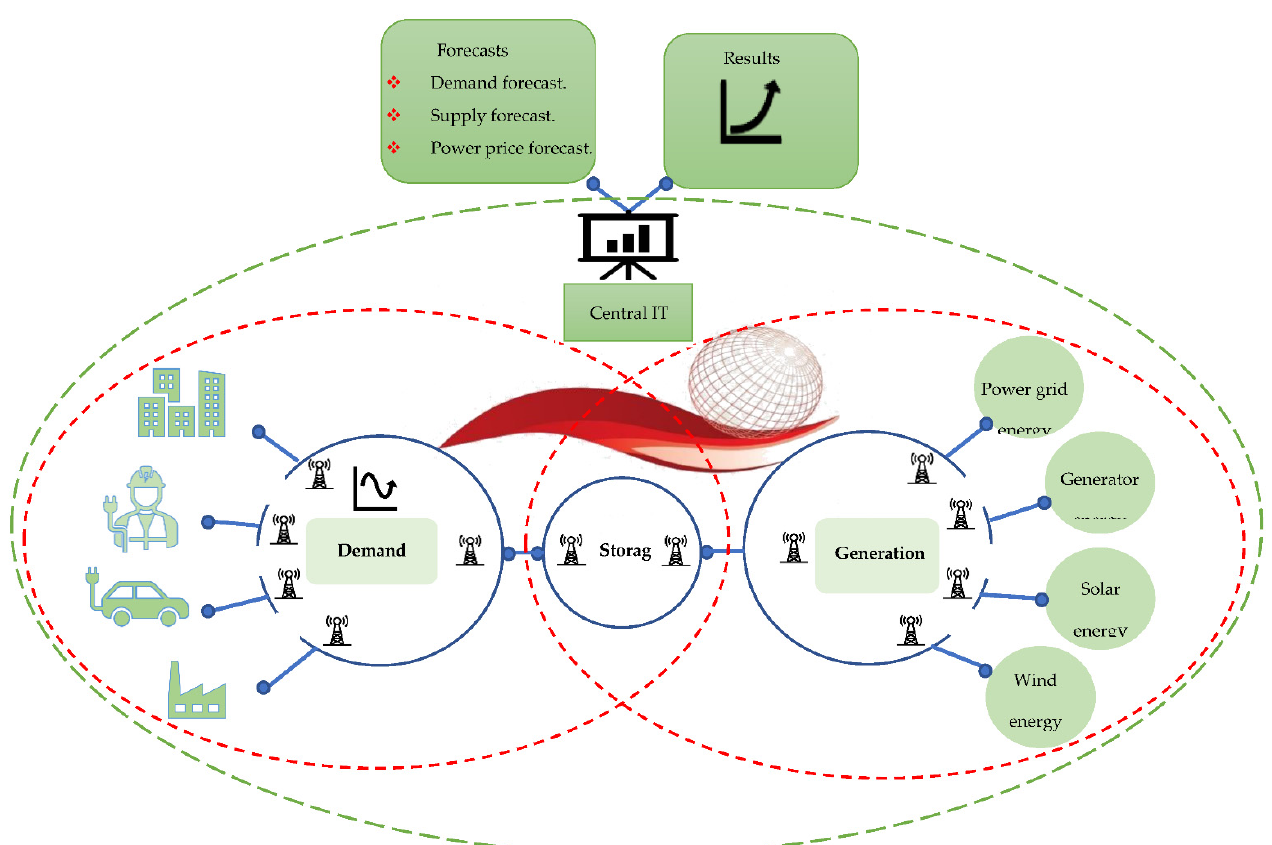
Figure 6. Schematic illustrating concepts of distributed energy